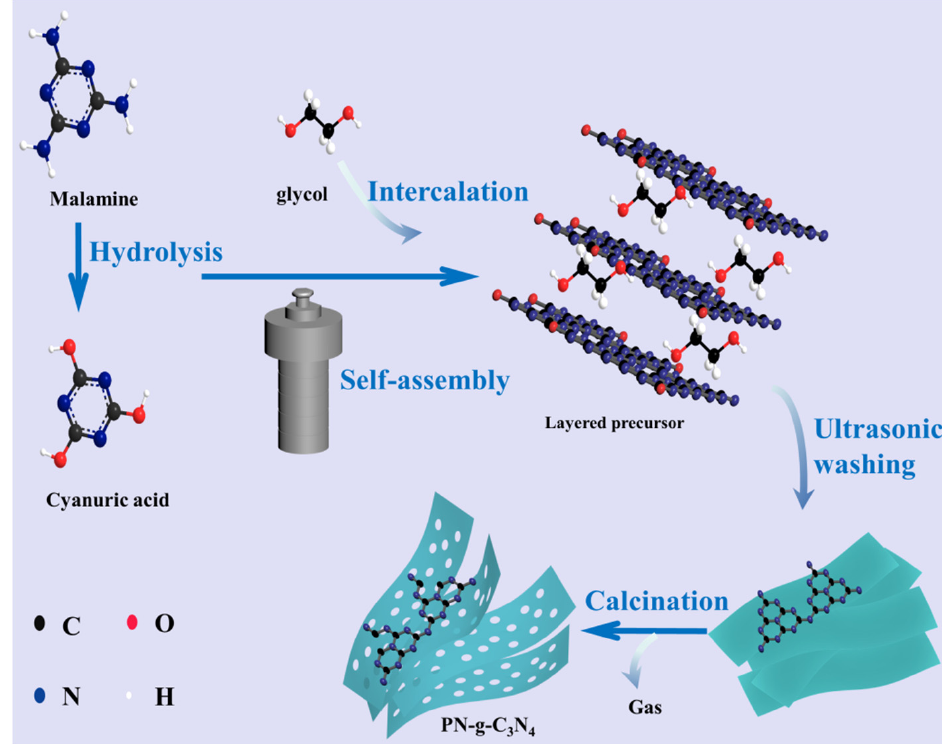
Figure 1. Schematic diagram on the fabrication of PN-g-C 3 N 4 photocatalyst.